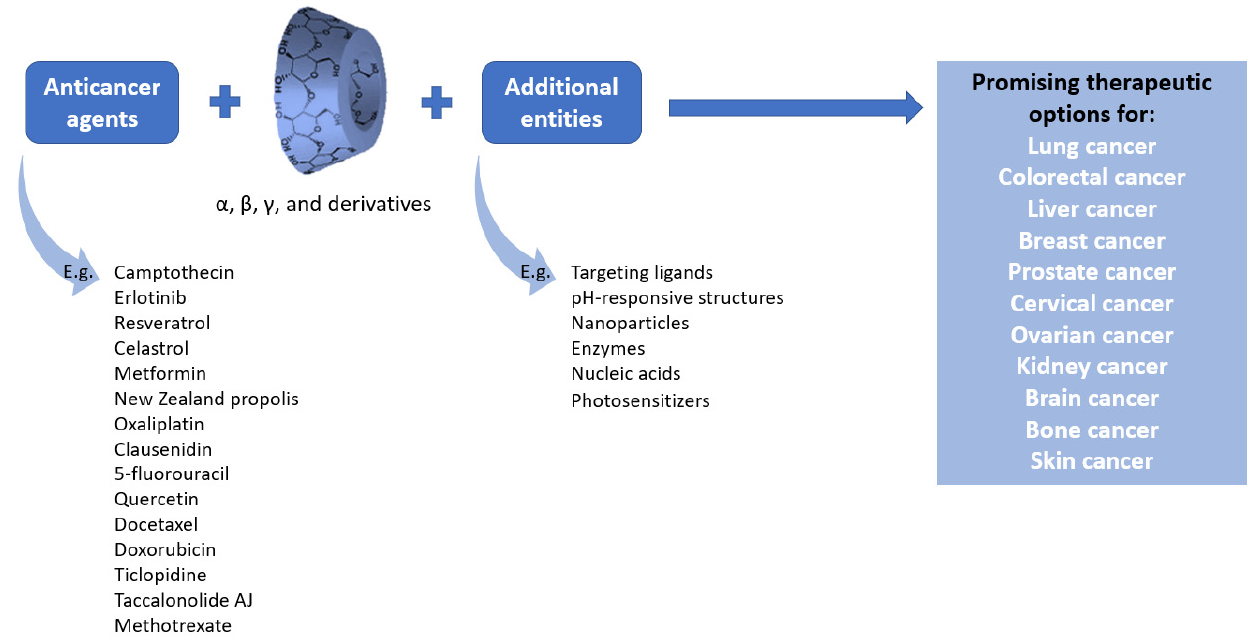
Figure 4. Overview of the main discussed possibilities of using CDs for the delivery of anti-cancer agents.